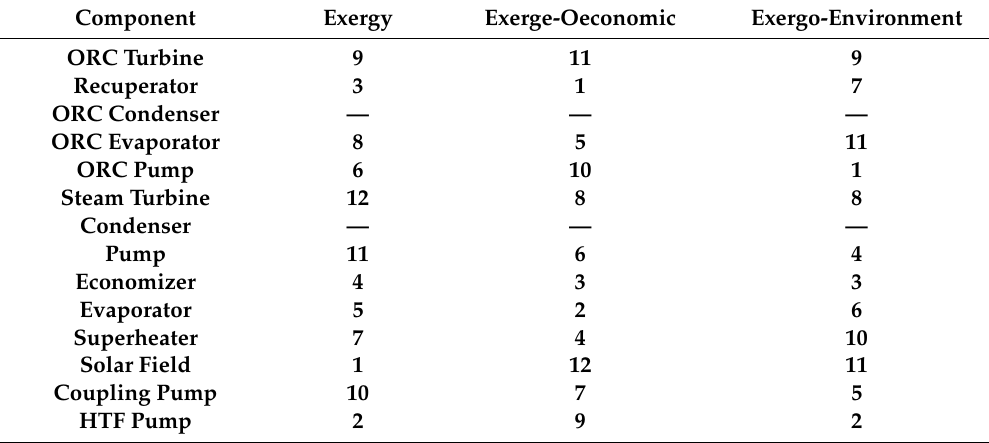
Table 19. Prioritized equipment for optimization in conventional exergy